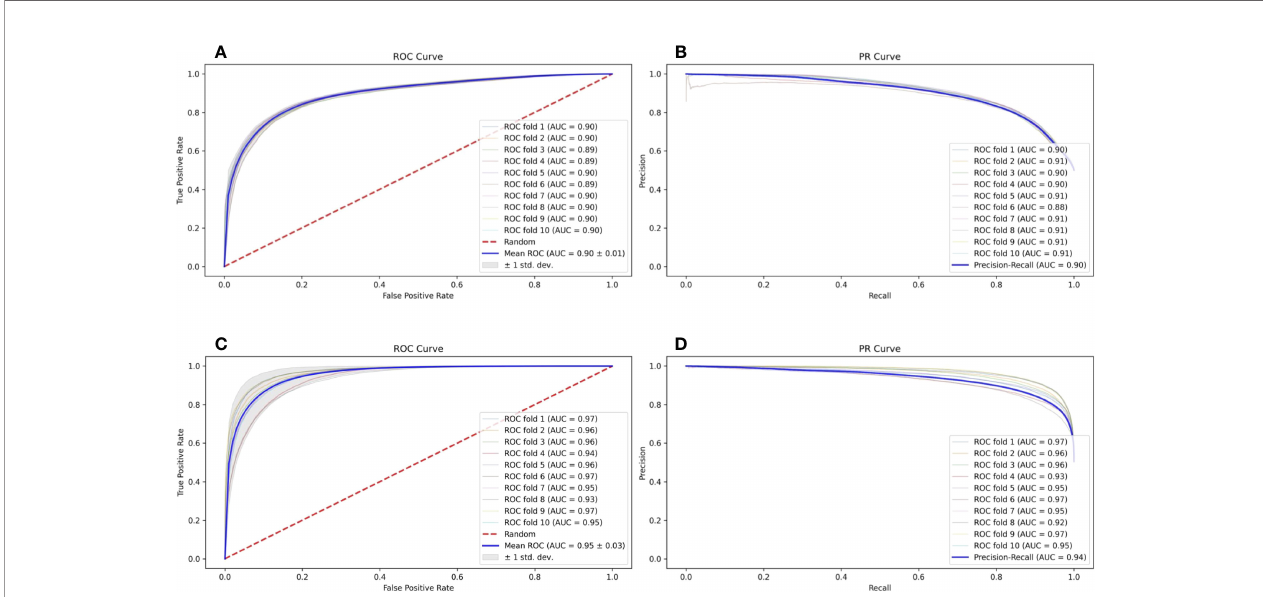
FIGURE 5 | In fl uence of balanced and unbalanced data ratios on FIONA-P. (A, B) are the ROC (receiver operating characteristic) curve and PR (precision and recall) curve of unbalanced data (AUC=0.90, PR=0.90), respectively, while (C, D) are the ROC curve and PR curve of balanced data (AUC=0.94, PR=0.95),